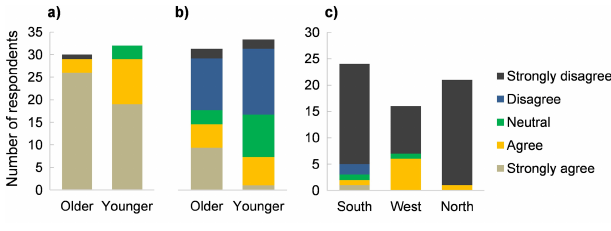
Fig. 5 . Differences in responses between older and younger farmers to the statements (a) I think it is important to have rich birdlife on my estate and (b) I take birdlife into consideration in land use management, and between farmers in different regions to the statement (c) I think delaying the timing of harvesting could be possible (see Figure 4 for statistical